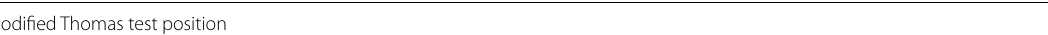
Table 2 Stretching exercises program 1. Stretch in the modified Thomas test position The subject lies in the supine position on the table and took the modified Thomas test ’ position. Meanwhile, the opposite leg was held actively by the participants with the hip and knee in a flexed position against the chest to stabilize the pelvis during the stretching exercise. First, the only force that leads to stretching flexor muscles hip was the weight of the tested limb and progressively a little force was applied in the direction of the knee exten- sion to stretch. The 30-s stretch is performed with 8 s of rest and 10 repetitions 2. Modified launch stretch Like the half-kneeling position on the floor with a towel or pillow under the knee. The body is straight and by going forward and bending the hip, maxi- mum tension is created in the hip on the side where the knee is bent. The 30-s stretch is performed with 8 s of rest and 10 repetitions [11]